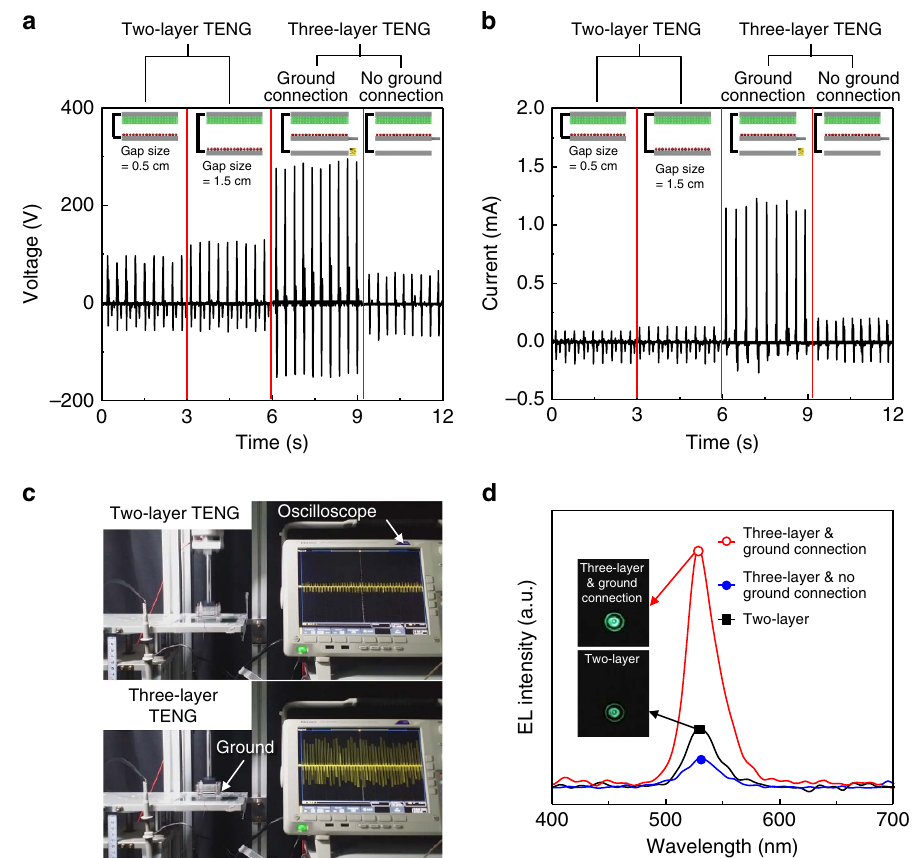
Figure 2 | Electrical outputs of triboelectric nanogenerator. ( a ) Output voltages and ( b ) currents of two-layer structured TENGs with gap sizes of 0.5 and 1.5cm, and three-layer structured TENGs with and without a ground connection. ( c ) Optical images of measuring output signals for three-layer structured TENGs with and without a ground connection. ( d ) Electroluminescence (EL) spectra for commercial green LEDs powered by two-layer and three-layer structured TENGs as a function of